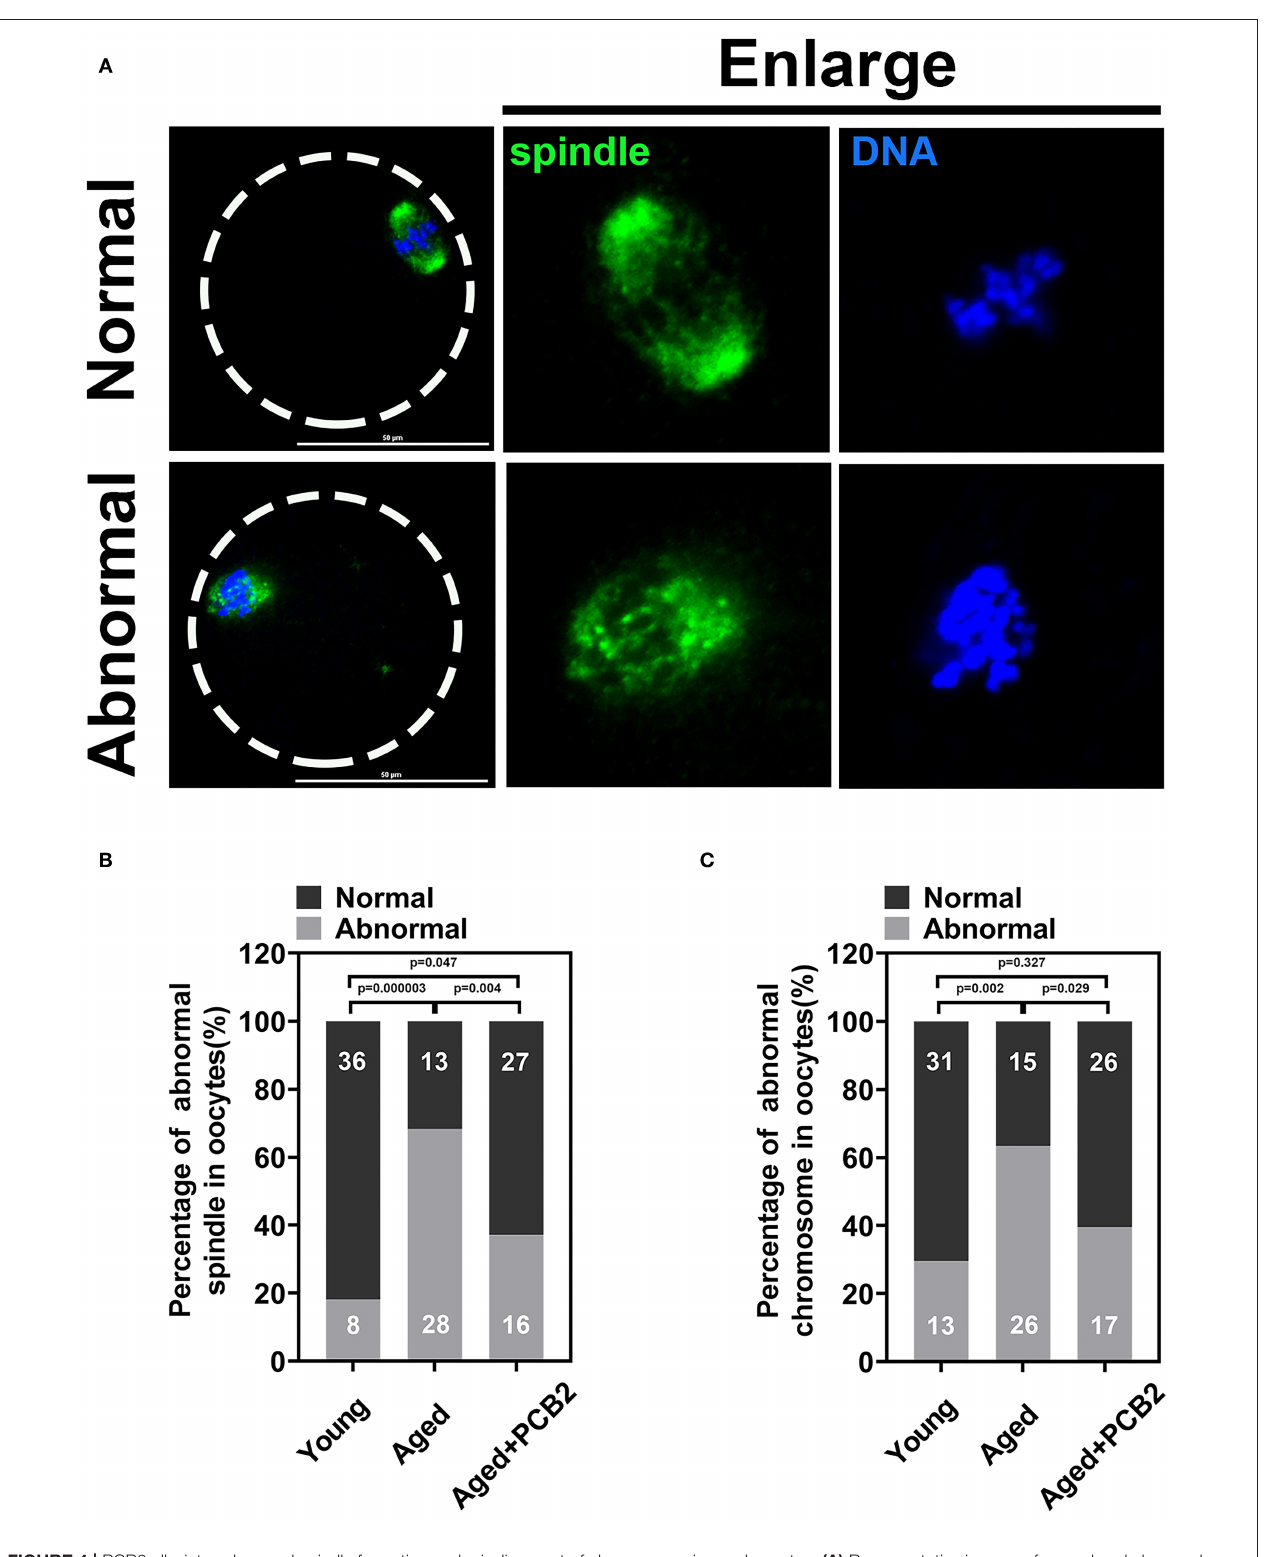
FIGURE 4 | PCB2 alleviates abnormal spindle formation and misalignment of chromosome in aged oocytes. (A) Representative images of normal and abnormal spindle formation as well as chromosome alignment. Scale bar, 50 µ m. (B) Quantification of normal and aberrant spindles was recorded in different groups. (C) Quantification of normal and misalignment chromosome was recorded in different groups. Chi-square test was performed for statistical analysis.